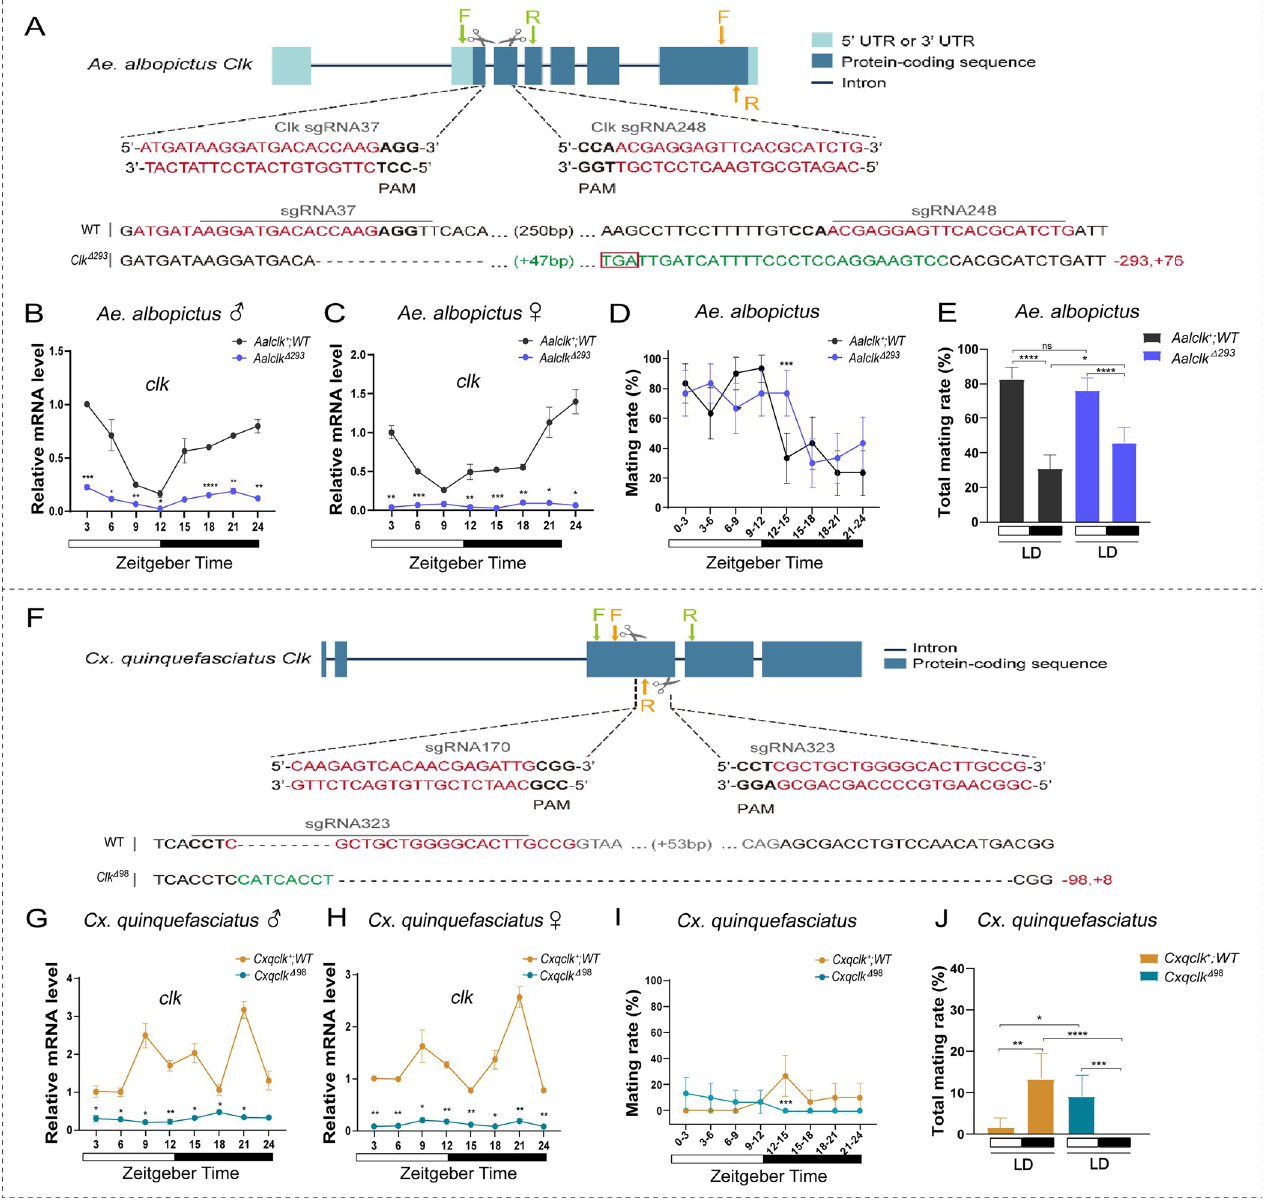
Fig 2. CRISPR/Cas9 - mediated clk mutagenesis and mating activities at different times of day in clk mutants. (A) Schematic diagram of sgRNA-targeting sites to induce clk mutations in Ae . albopictus using CRISPR/Cas9 technology. The scissors represent the corresponding position of sgRNA in the genome. The red sequence is sgRNA and the gray sequence is intron sequence. The dotted line indicates base deletion and the green sequence indicates base insertion. The number in brackets indicates the number of omitted bases on the genome. The red box highlights the stop codon. The number at the end of the sequence indicates the number of inserted or missing bases on the genome. Green arrows indicate mutation identification primer positions, yellow arrows indicate the positions of qPCR detection primers. ( B-C ) Temporal expression patterns of clk mRNA between WT ( Aalclk + ) and Aalclk Δ 293 under LD cycles. The abundance of clk mRNA was measured by qRT-PCR. Total RNA was extracted from 10 males or 10 females heads at 3h intervals. White and black bars indicate light phase and dark phase, respectively. (B) Ae . albopictus males, ( C ) Ae . albopictus females. ( D ) Daily changes in mating activities between WT ( Aalclk + ) and Aalclk Δ 293 under LD cycles. ( E ) Total mating rates between WT ( Aalclk + ) and Aalclk Δ 293 during daytime and nighttime. (F ) Schematic diagram of sgRNA-targeting sites to induce clk mutations in Cx . quinquefasciatus using CRISPR/Cas9 technology. (G-H) Temporal expression patterns of clk mRNA between WT ( Cxqclk + ) and Cxqclk Δ 98 under LD cycles. ( G ) Cx . quinquefasciatus males, ( H) Cx . quinquefasciatus females. (I) Daily changes in mating activities between WT ( Cxqclk + ) and Cxqclk Δ 98 under LD cycles. ( J ) Total mating rates between WT ( Cxqclk + ) and Cxqclk Δ 98 during daytime and nighttime. For the relative mRNA level, statistics were performed using Student t-test and error bars represent the standard error of mean (SEM). Each treatment was replicated three times. For mating rate between two groups at a certain time, statistics were performed using GLM with binomial distribution and error bars represent 95% confidence intervals (CIs). Each mosquito was measured only once. n = 28–30 for each point. � P < 0.05, �� P < 0.01, ��� P < 0.001, ���� P < 0.0001.